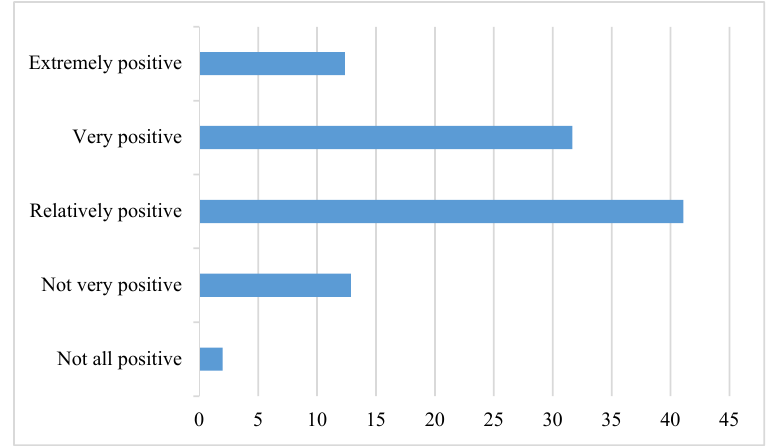
Figure 8. TripAdvisor’s contribution toward firm success (%).